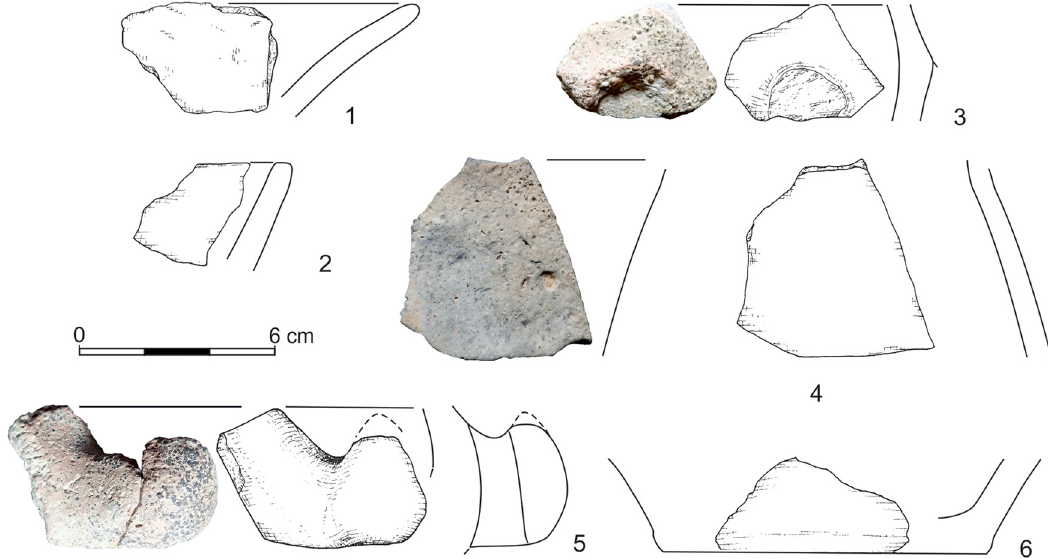
Figure 6: Czchów, com. loco, site 10. Ceramics with the features of Modlnica